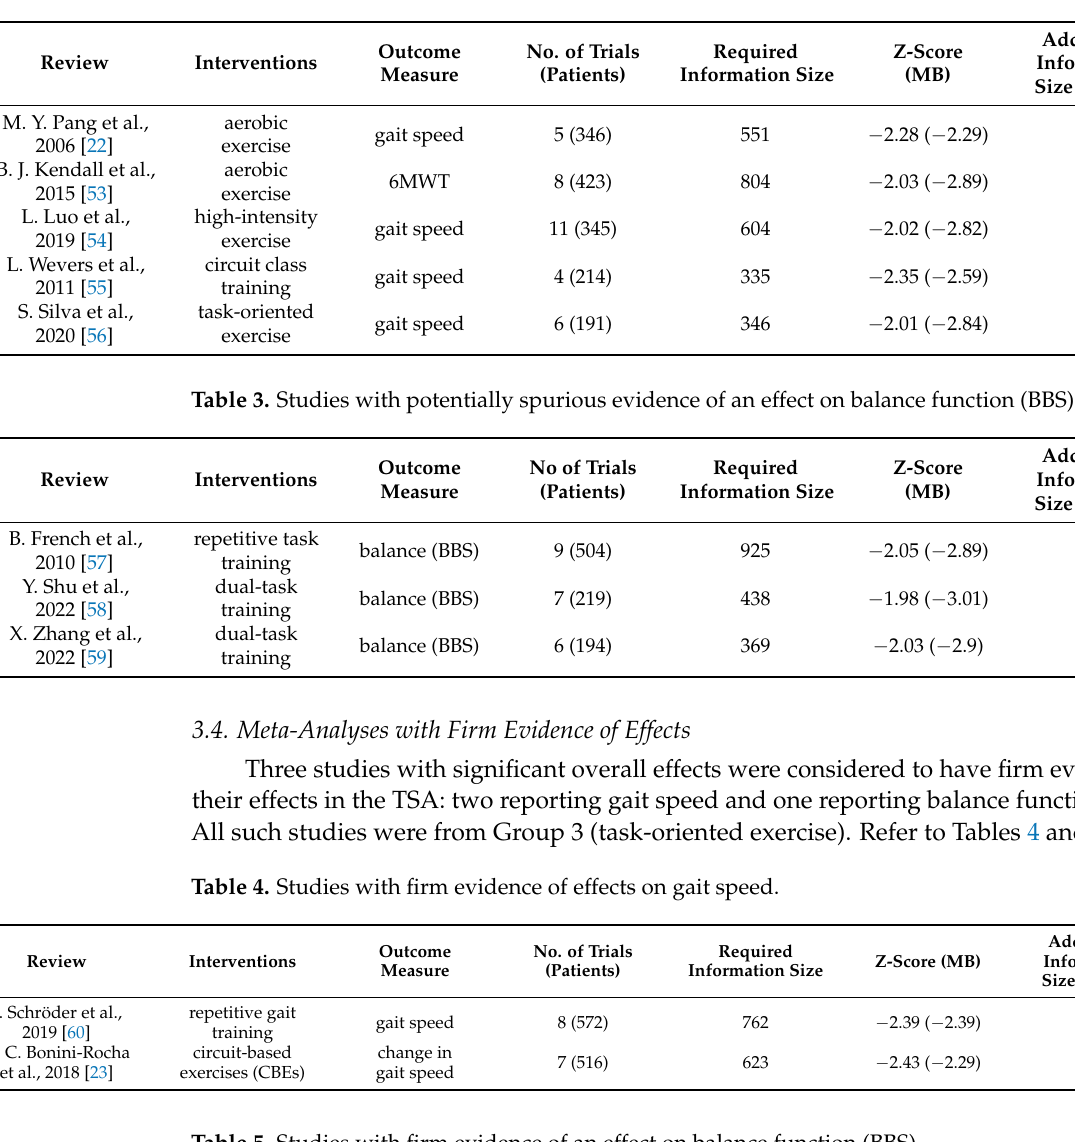
Table 2. Studies with potentially spurious evidence of effects on gait speed.